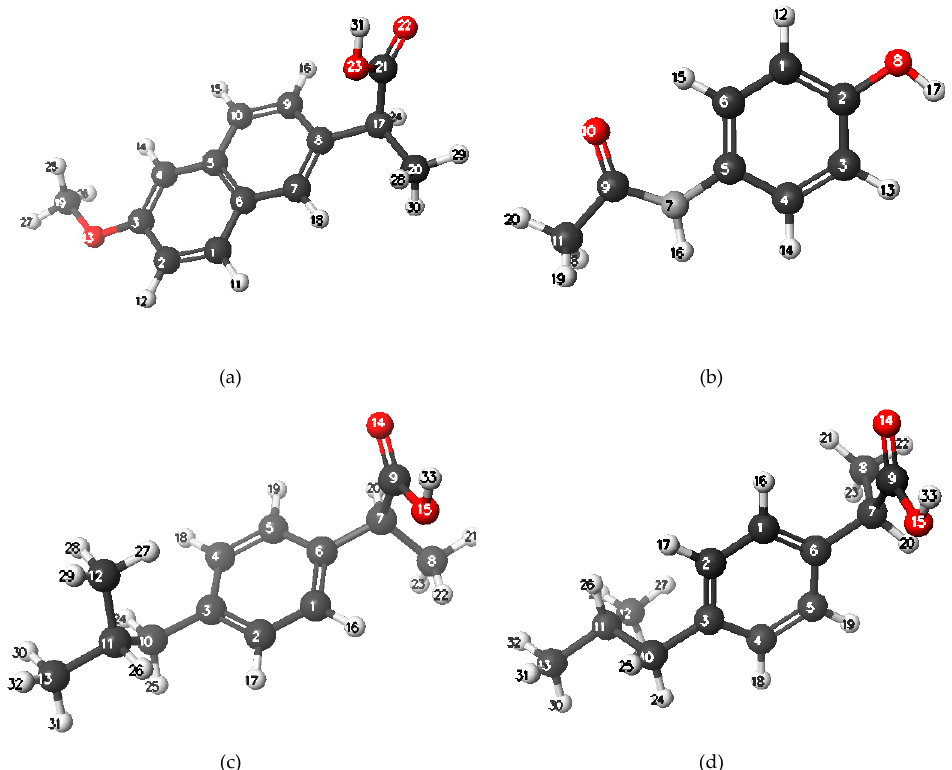
Figure 1. Optimized chemical structure of ( a ) ( S )-naproxen, ( b ) paracetamol, ( c ) ( S )-ibuprofen, ( d ) ( R )-ibuprofen obtained by DFT calculation in Scigress program. Particular atoms were marked with colors: carbon–black, hydrogen–white, nitrogen–light gray, oxygen–red. Table 2. Calculation results for ( S )-naproxen, paracetamol, ( S )-ibuprofen and ( R )-ibuprofen obtained in SCIGRESS program.